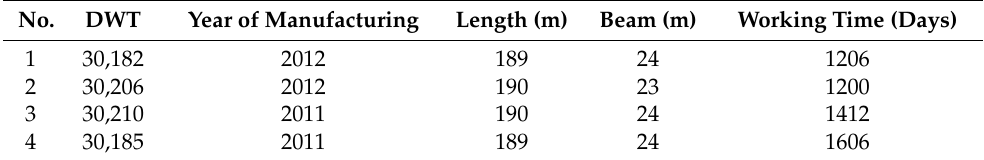
Table 1. Basic data of ships whose manholes were